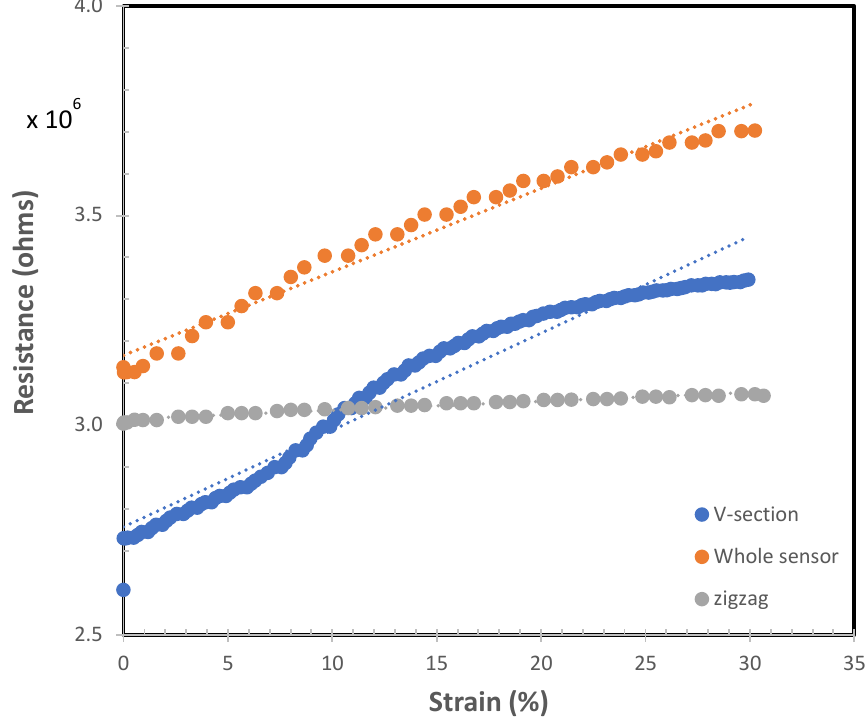
Figure 6. The resistance versus linear strain of the PIP sensing element shows the relationship of the V-section, zig-zag section, and the whole sensor.